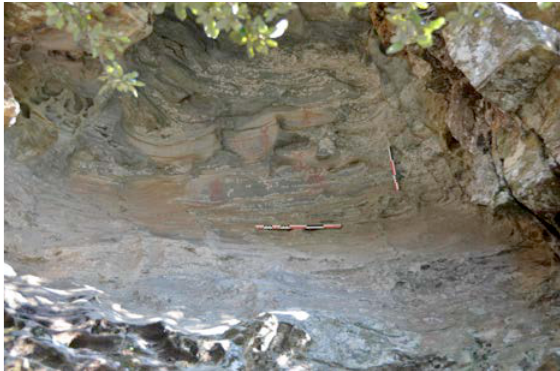
Figure 3. Upper part of the rock-shelter (dome) showing the parietal representations and the location of two scale bars (photo P. Grussenmeyer)